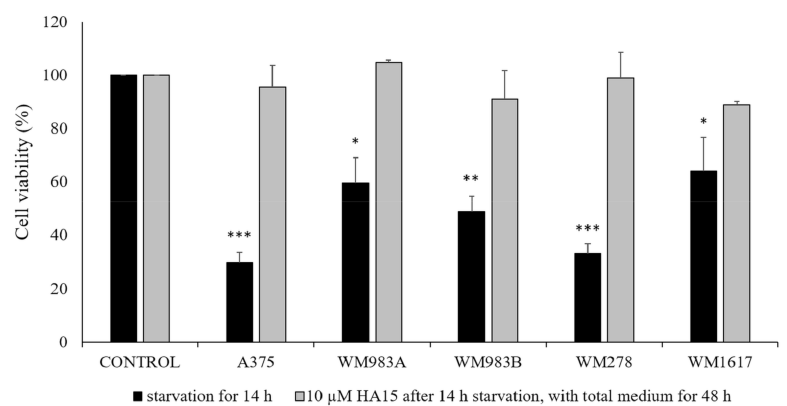
Figure 4. Cell viability of BRAFV600E -mutant melanoma cell lines (A375, WM983A, WM983B, WM278, WM1617) treated with 10 µ M of HA15 for 48 h. Before drug treatment, the cells were starved for 14 h (black columns); the medium was then replaced with complete medium containing 10 µ M of HA15, and the cell viability was measured after 48 h (grey columns) using the WST-1 assay. Data represent the mean viability of three independent experiments ± SD. Significant differences (* p ≤ 0.05; ** p ≤ 0.01; *** p ≤ 0.001) are indicated by asterisks.